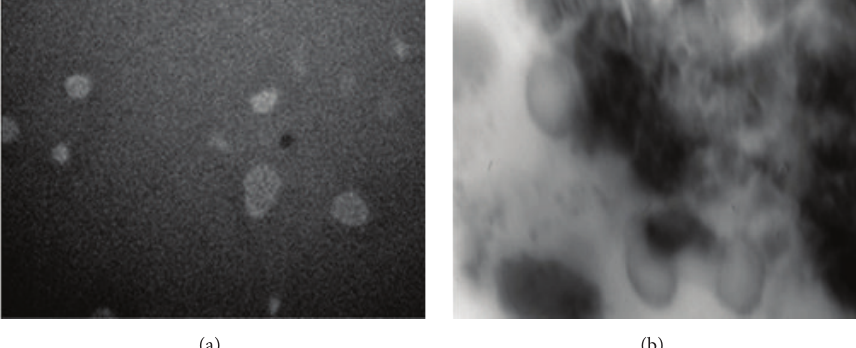
Figure 2: TEM image of NC 2 formulation prepared at 1: 1 ratio of cholesterol and Span with different magnification. (a) 40,000x and (b) 45,000x.